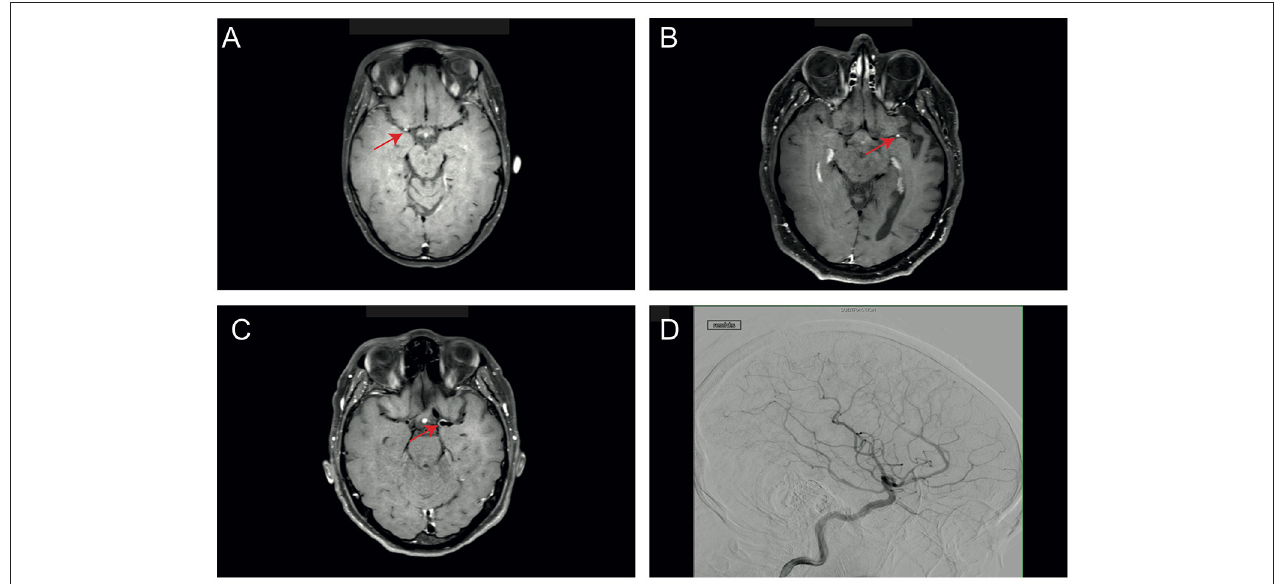
FIGURE 1 | Representative imaging findings in PACNS patients. (A–C) Images of patients 1–3 with black-blood contrast-enhanced T 1 weighted sequences, which show contrast enhancement in the vessel walls (red arrow). (D) Angiography image of PACNS patient 4 with longest duration of diseases showing pathognomonic blood vessel irregularities such as